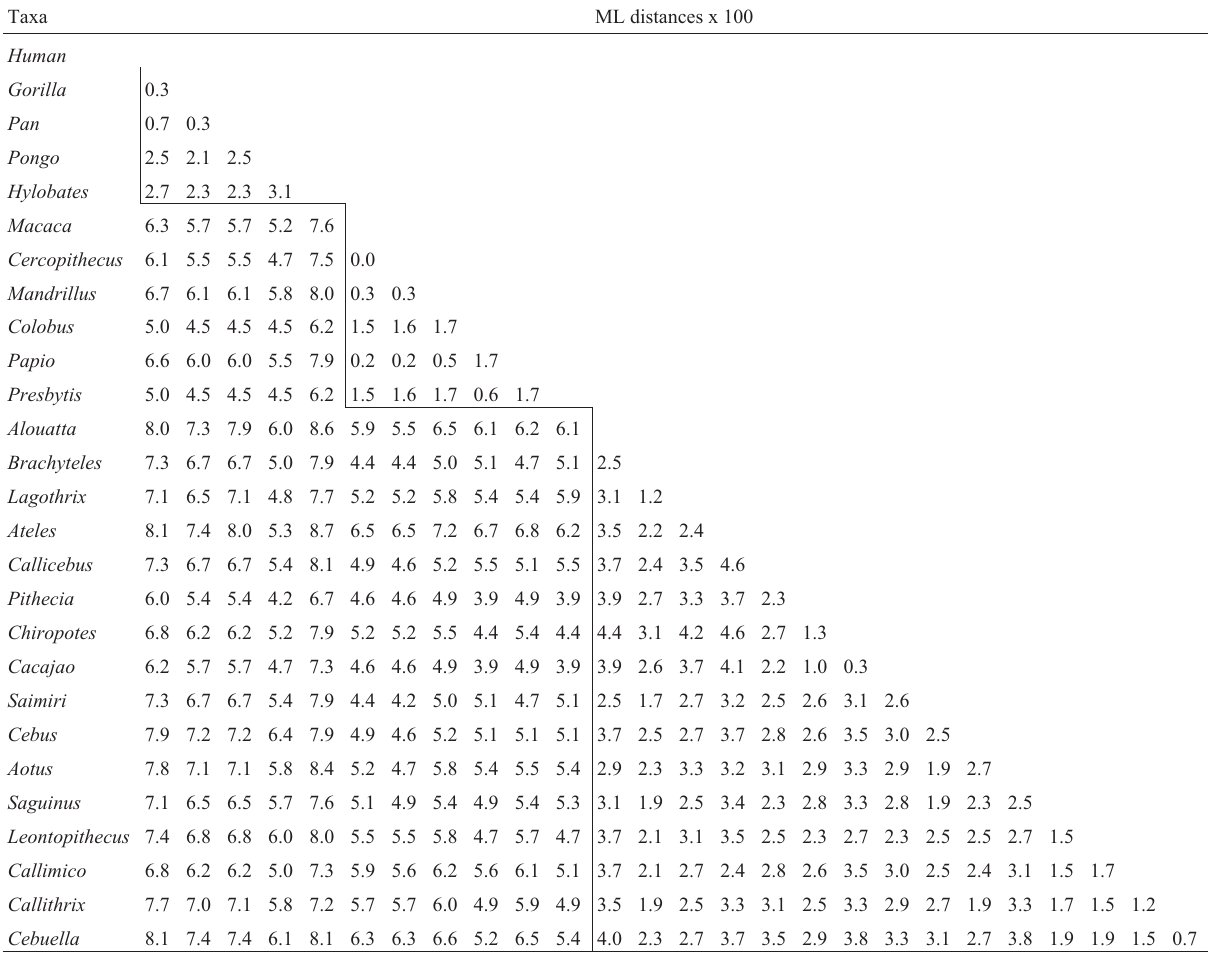
Table 1 - Genetic distances estimated using likelihood settings from best-fit model (F81+G) selected by hierarchical likelihood ratio test (LRT) in Modeltest Version 3.06.